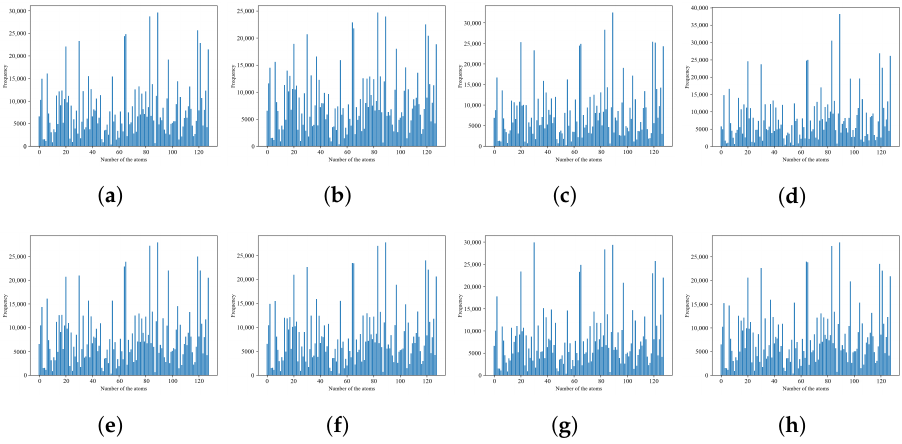
Figure 10. Histograms of occurrence number of each atom for image in Figure 1c with different distortion types. ( a ) Pristine image, ( b ) GN, ( c ) GB, ( d ) MB, ( e ) CC, ( f ) JPEG, ( g ) J2K, ( h ) LSC.